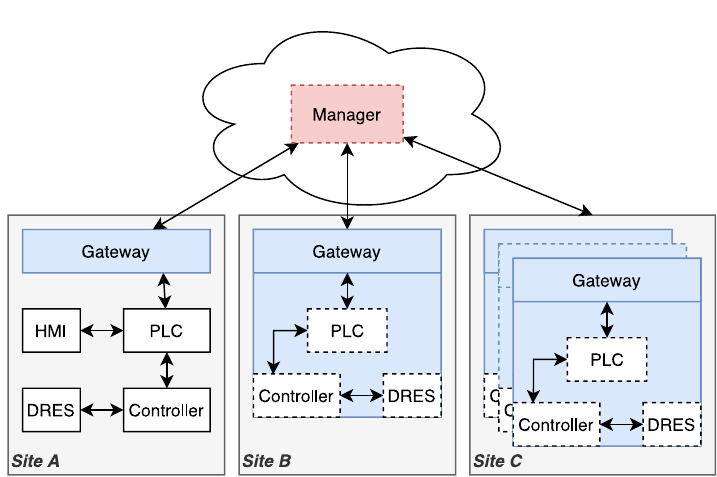
Fig. 4 Testbed system architecture. Solid boxes indicate physical assets, dashed boxes indicate virtualised